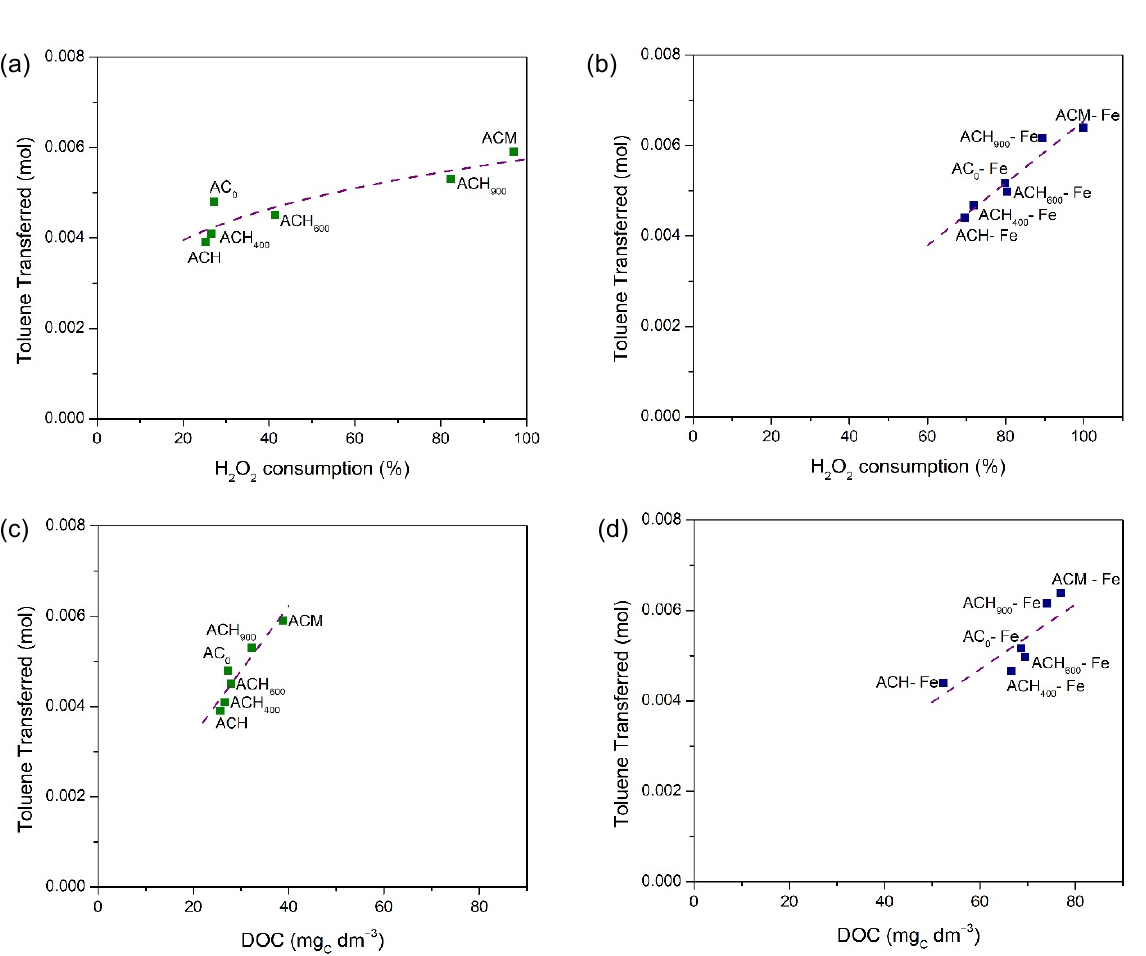
Figure 8. Correlations between the amount of toluene transferred and H 2 O 2 consumption for metal-free activated carbons ( a ) and for Fe-derived catalysts ( b ); and final DOC concentrations for metal-free activated carbons ( c ) and for Fe-derived catalysts ( d ).